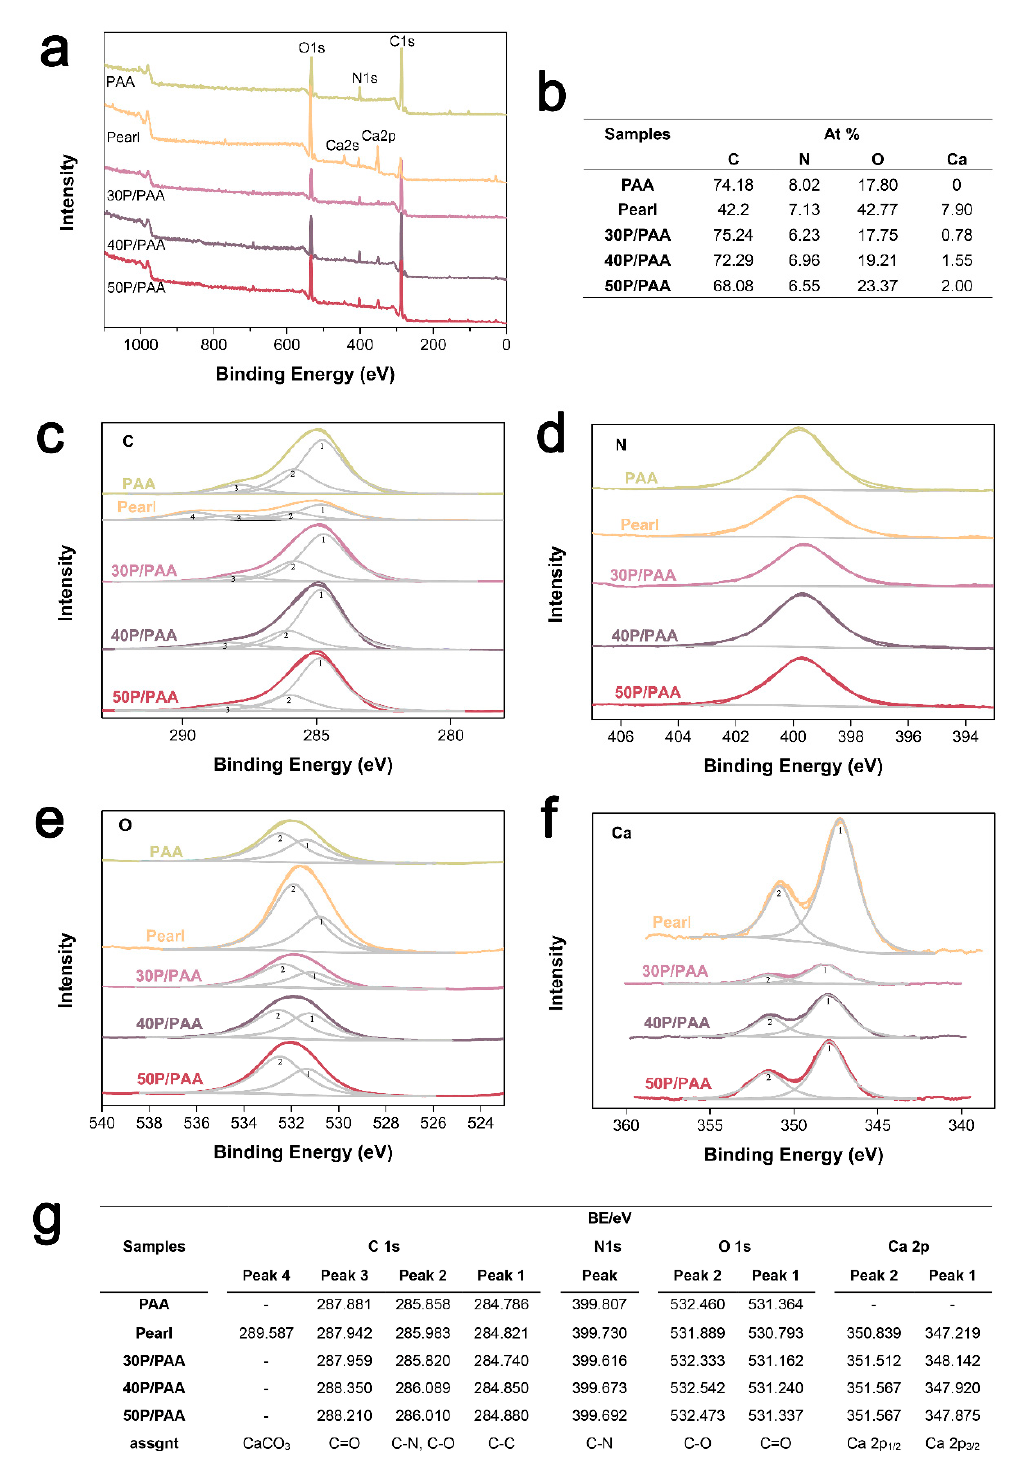
Figure 3. XPS spectra of the pearl, PAA, and the P/PAA composites. ( a ) XPS wide spectra, ( b ) atomic concentration (at%) of surface elements as detected by XPS, high-resolution XPS spectra of ( c ) C 1s, ( d ) N 1s, ( e ) O 1s, and ( f ) Ca 2p, ( g ) The binding energy (BE) for C 1s, N 1s, O 1s, and Ca 2p in different states in samples.